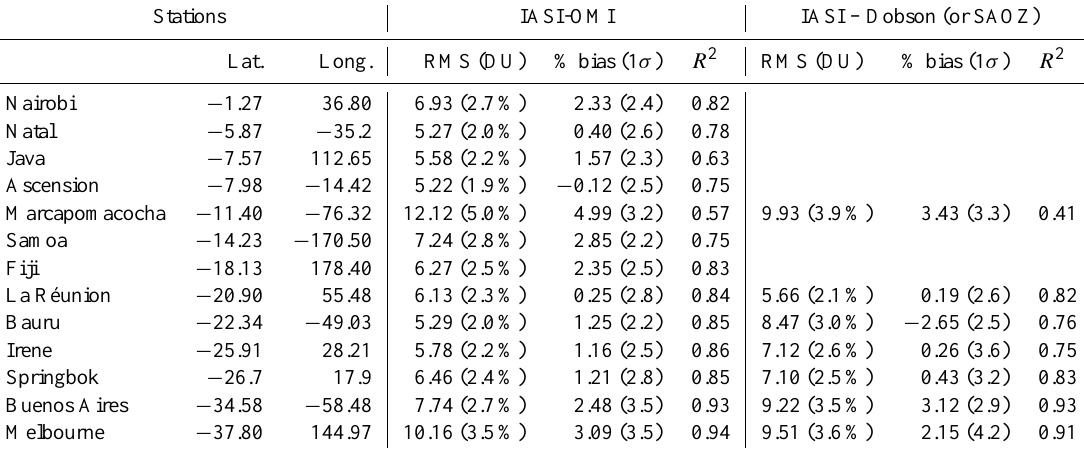
Table 1. Bias, absolute and relative RMS and correlation coefficient R 2 obtained from the comparative study between IASI and the other instruments (OMI, Dobson and SAOZ) over the subtropical and tropical selected sites. Comparison between IASI and SAOZ instruments is performed only for Réunion and Bauru stations, while the comparison between IASI and Dobson has been made for Marcapomacocha, Irene, Springbok, Buenos Aires and Melbourne stations. Stations IASI-OMI IASI – Dobson (or SAOZ)